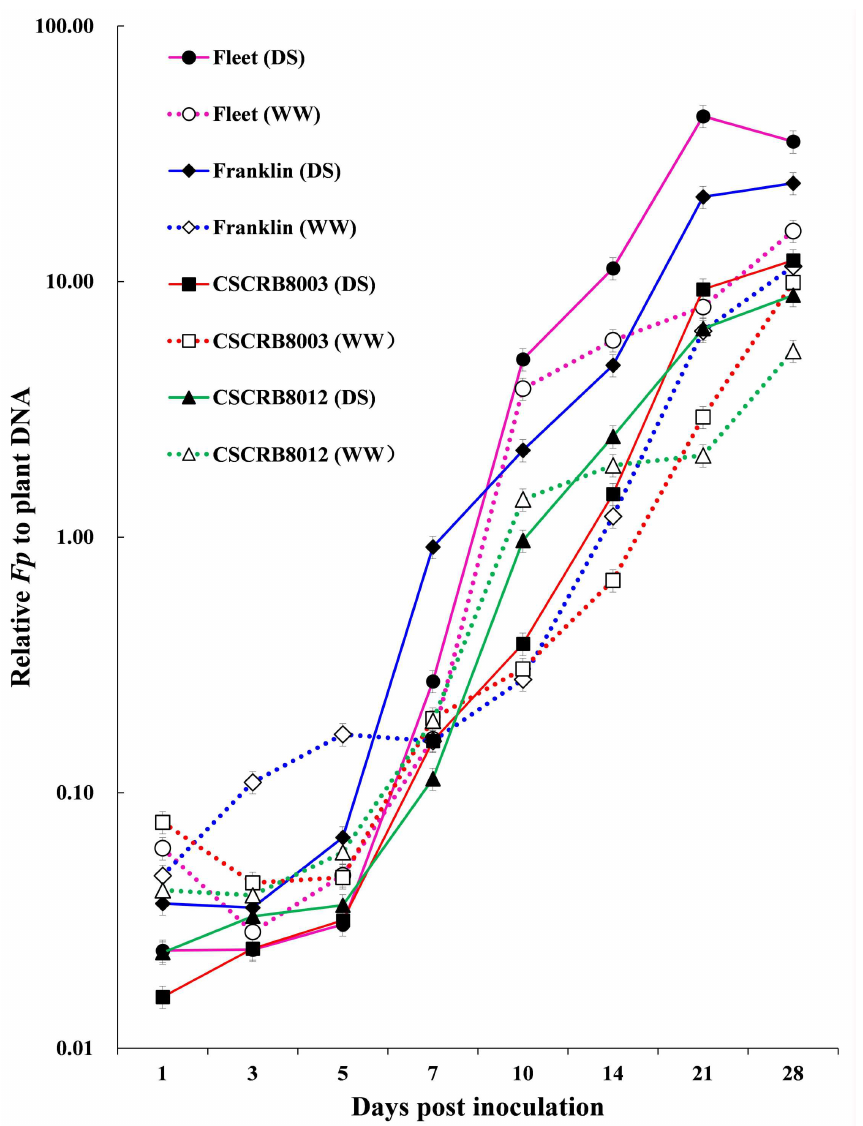
Fig 2. Relative Fusarium pseudograminearum biomass obtained by real-time quantitative PCR at different time points during Fusarium crown rot infection and development. DS: drought-stressed treatment; WW: well-watered